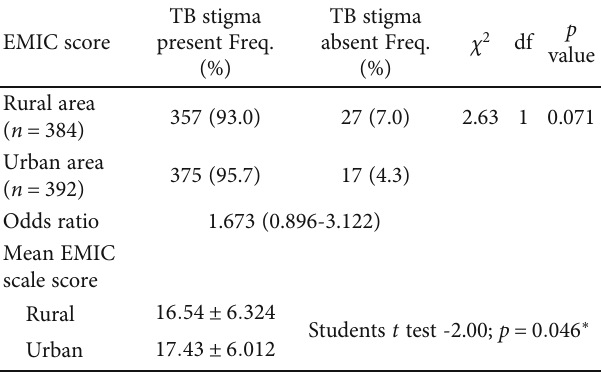
Table 6: TB-associated stigma in the